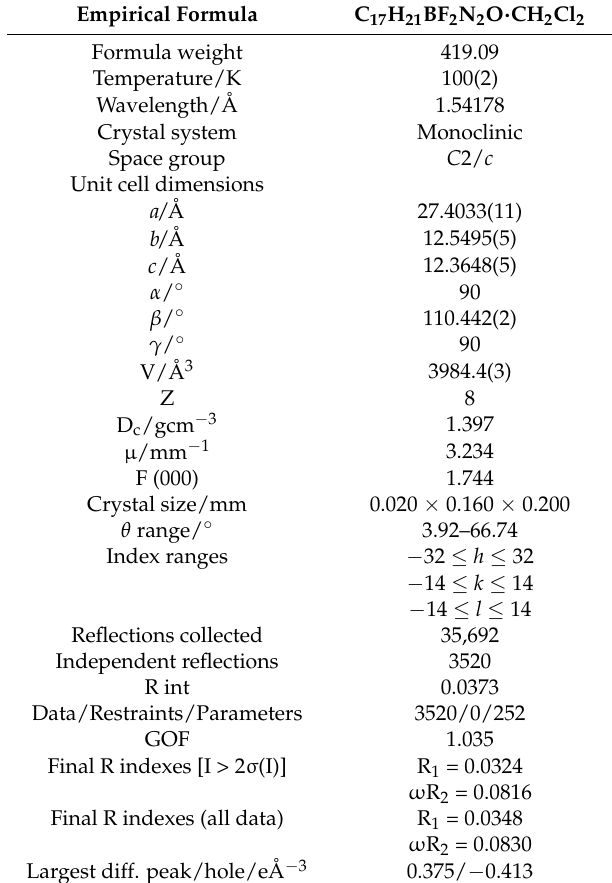
Table 1. Crystal data and structure refinement parameters for compound 1